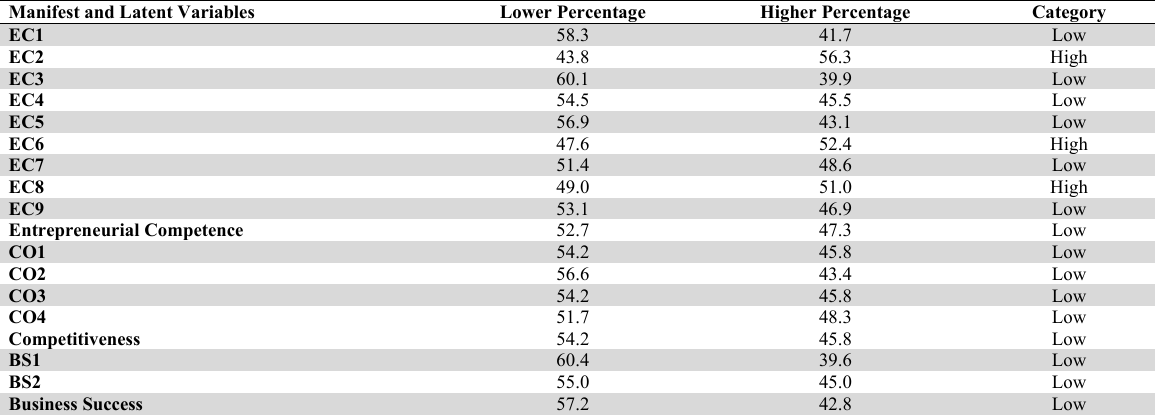
Percentage of Manifest and Latent Variables Manifest and Latent